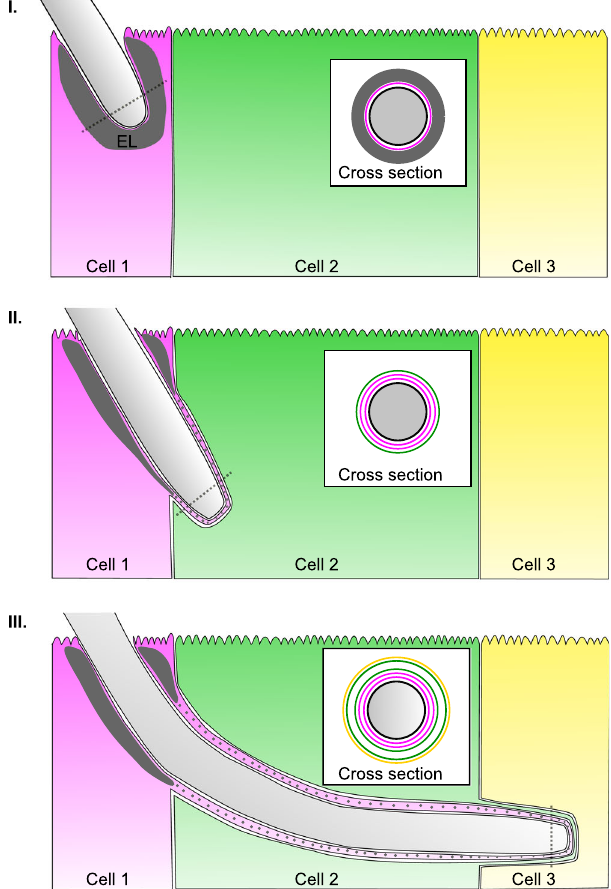
Fig. 6 Model of C. albicans trans-cellular tunnelling (CaTCT). A model based on the hypothesis that host membranes extend from each invaded cell into the next host cell in the invasion sequence, resulting in progressive membrane layer accumulation. Alternatively, additional membrane layers may be recruited from internal host endocytic compartments or formed de novo in each invaded cell in correspondence with the invasion sequence, though we reason these are less likely possibilities (see Discussion). These latter models are not presented. I Invasion into the fi rst cell in the invasion sequence (cell 1) is characterized by tight enveloping by the cell 1 plasma membrane as well as an ‘ exclusion layer ’ (EL), likely containing actin derived from the apical actin cortex. II At the onset of invasion into the second cell in the sequence (cell 2), the structures surrounding the hypha in cell 1, i.e. cell 1 plasma membrane (added during cell 1 entry), and another cell 1 plasma membrane (added during cell 1 exit), are enveloped by the plasma membrane of cell 2. Parts of the exclusion layer in cell 1 may possibly also extend into the TCT structure (grey dots). III Invasion into cell 3 proceeds in a similar manner, with the structures surrounding the hypha in cell 2 enveloped by the plasma membrane of cell 3. Cross-section views (derived from dotted lines) show the membrane layers surrounding the hypha cell wall (black), with the exclusion layer in dark grey, and each membrane layer coloured according to its cell of origin, i.e. magenta- cell 1, green- cell 2, yellow- cell 3. Additional actin layers derived from non-apical cortical actin may also be present within the TCT structure, but they were not illustrated for clarity. The model presented applies to non-damaging invasion, and does not account for scenarios where host membrane breaching